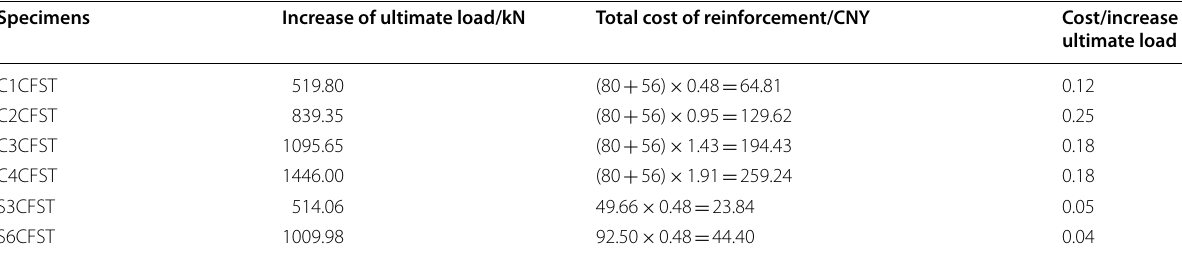
Table 3 Cost analysis of two different strengthening methods Specimens Increase of ultimate load/kN Total cost of